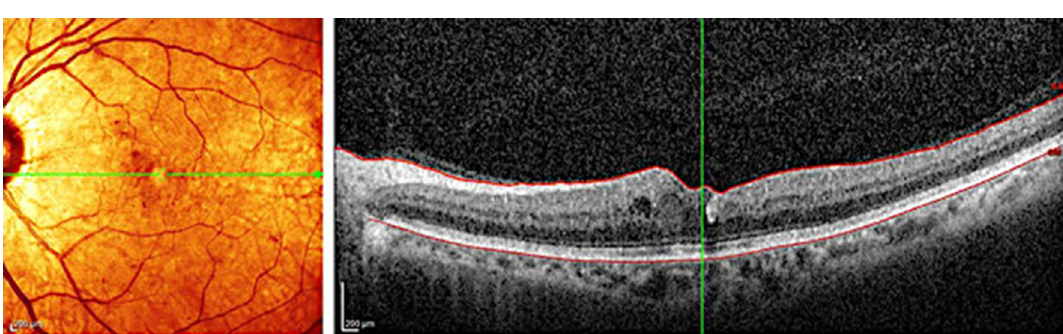
Figure 3. A post-treatment spectral-domain optical coherence tomography scan of the same eye following micropulse macular laser demonstrates improvement in diabetic macular edema and reduction of foveal